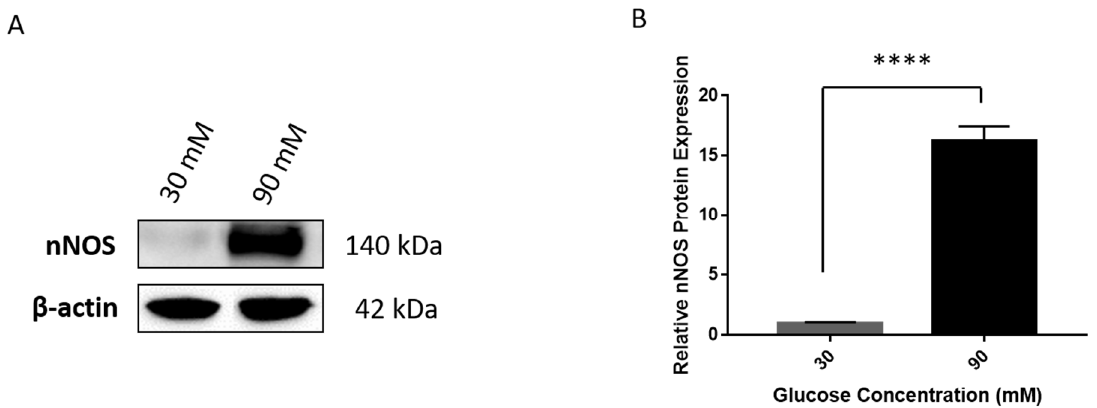
Figure 11. Protein expression of nNOS at 30 mM and 90 mM glucose concentrations in differentiated PDGFR α -positive cells. ( A ). Western blot images for nNOS observed at 140 kDa and the loading control β -actin at 42 kDa on the same blot. ( B ). The corresponding histogram of nNOS protein expression calculated relative to β -actin with a highly significant expression observed at 90 mM (**** p < 0.0001; n = 2) as compared to 30 mM glucose treatment.